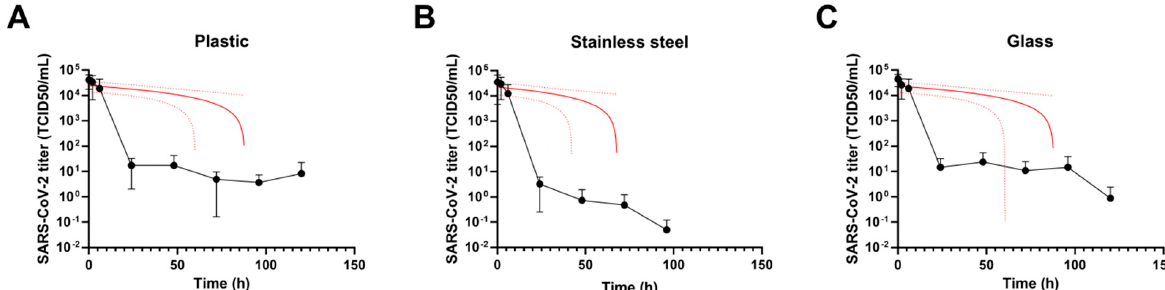
Figure 1. Severe acute respiratory syndrome coronavirus 2 (SARS-CoV-2) persistence on ( A ) plastic, ( B ) stainless steel and ( C ) glass. Ten microliters of SARS-CoV-2 viral stock were placed on different materials under controlled conditions (23–25 ◦ C and 40%–50% relative humidity). Infectious virus particles were carefully recovered at different time points (0 to 120 h) and processed for Median Tissue Culture Infectious Dose (TCID50) determination. SARS-CoV-2 infectivity kinetics (lines with filled dots) and linear regression analysis (red lines) are shown. Results are expressed as the mean ± standard deviation of 3 independent experiments ( n = 3).